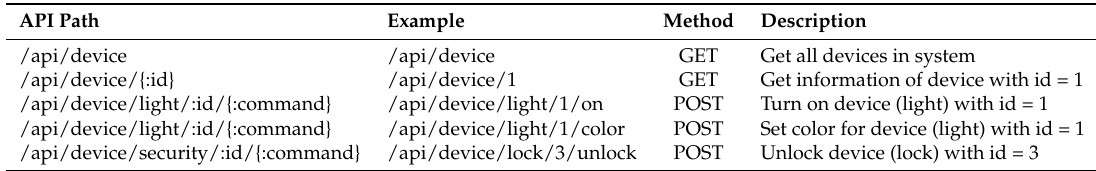
Table 3. Example Format of RESTful APIs in The